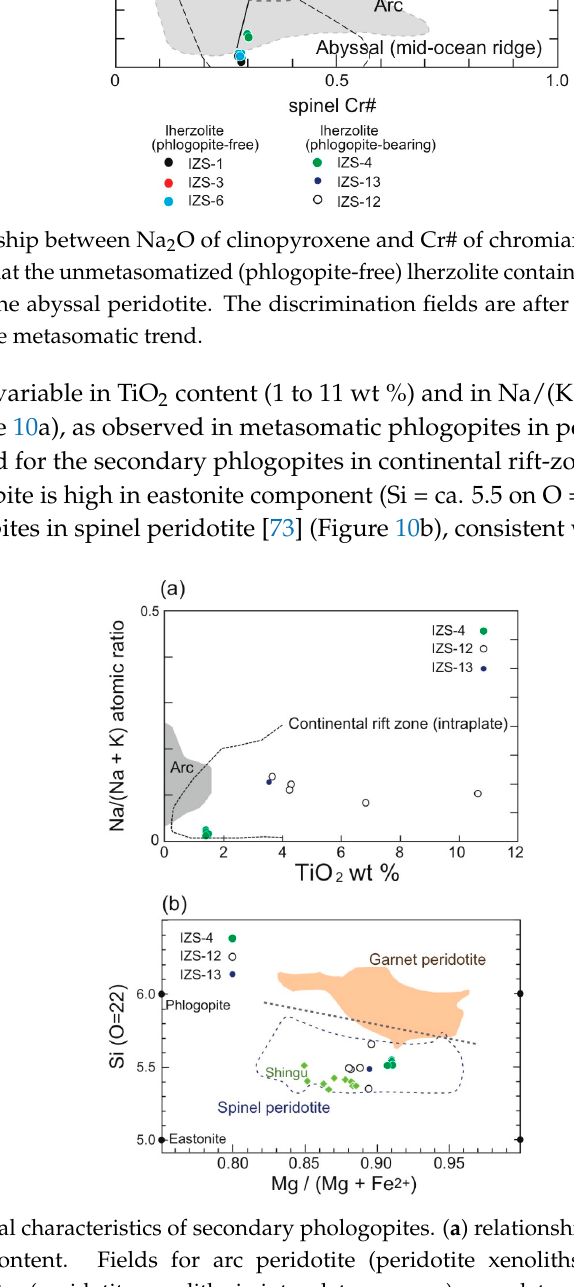
Figure 10. Chemical characteristics of secondary phologopites. ( a ) relationship between Na/(Na + K) ratio and TiO 2 content. Fields for arc peridotite (peridotite xenoliths in arc magmas) and intraplate peridotites (peridotite xenoliths in intraplate magmas) were determined from the literature data [18,19,71,74–80]. Note that abyssal peridotites only rarely contain phlogopites [81]; ( b ) relationship between Si content (number of Si on O=22) and Mg/(Mg + Fe 2+ ) atomic ratio. Fields for garnet peridotite and spinel peridotite are after Arai [73]. Phlogopites from metasomatized peridotite xenolith from Shingu [82] (Figure 1) are plotted for comparison.